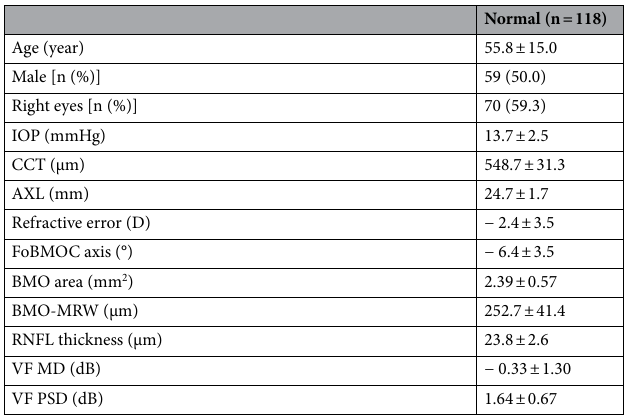
Table 1. Demographics and characteristics of participants. AXL axial length, BMO Bruch’s membrane opening, CCT central corneal thickness, D diopter, FoBMOC Fovea-to-BMO-Center, IOP intraocular